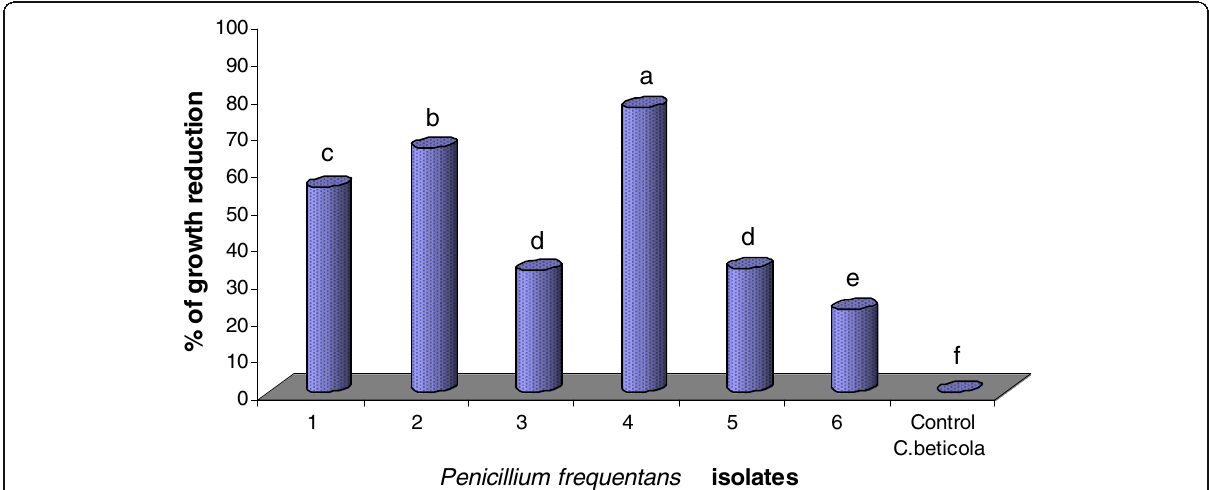
Fig. 1 Antagonistic effect of Penicillium frequentans isolates on the growth of Cercospora beticola in vitro. Different letters indicate significant differences among isolates according to Duncan ’ s multiple range test ( P <